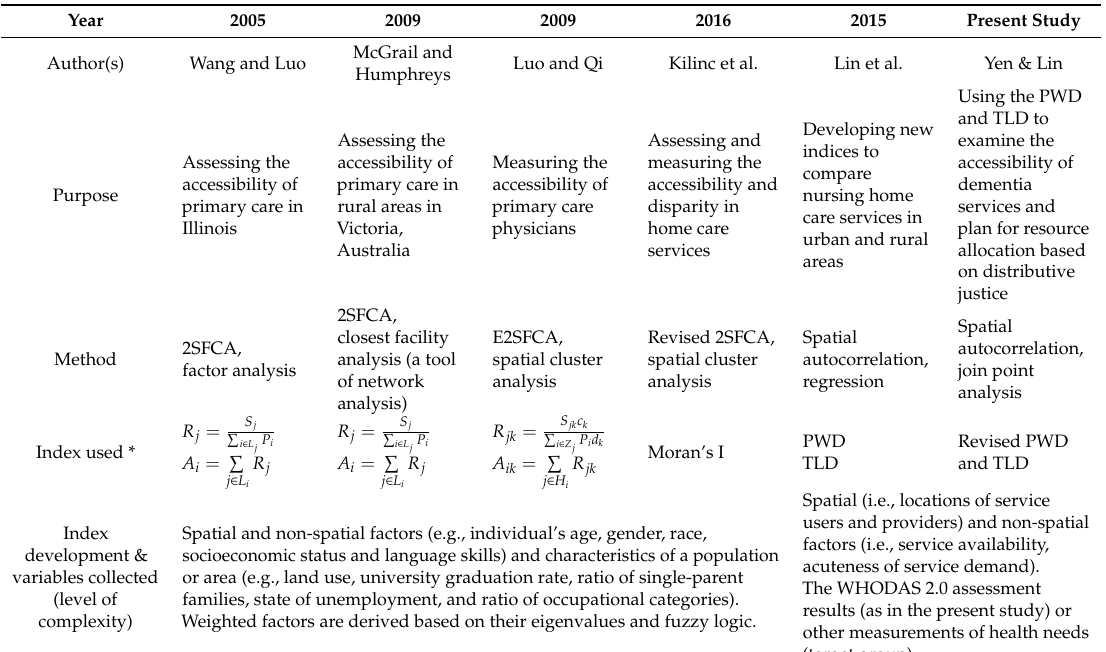
Table 6. A comparison of the other measurements with PWD and TLD for policy planning of medical and long-term